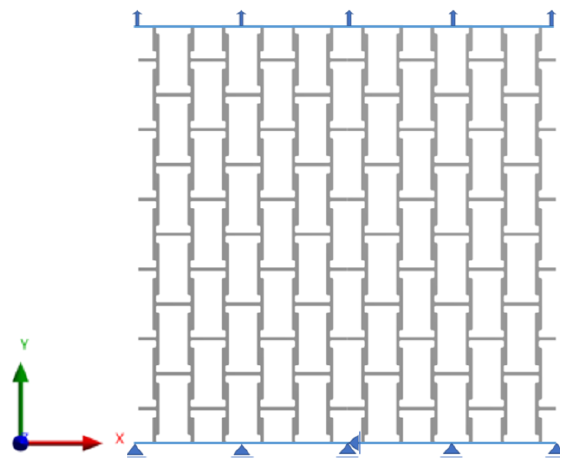
Figure 7. Boundary conditions.